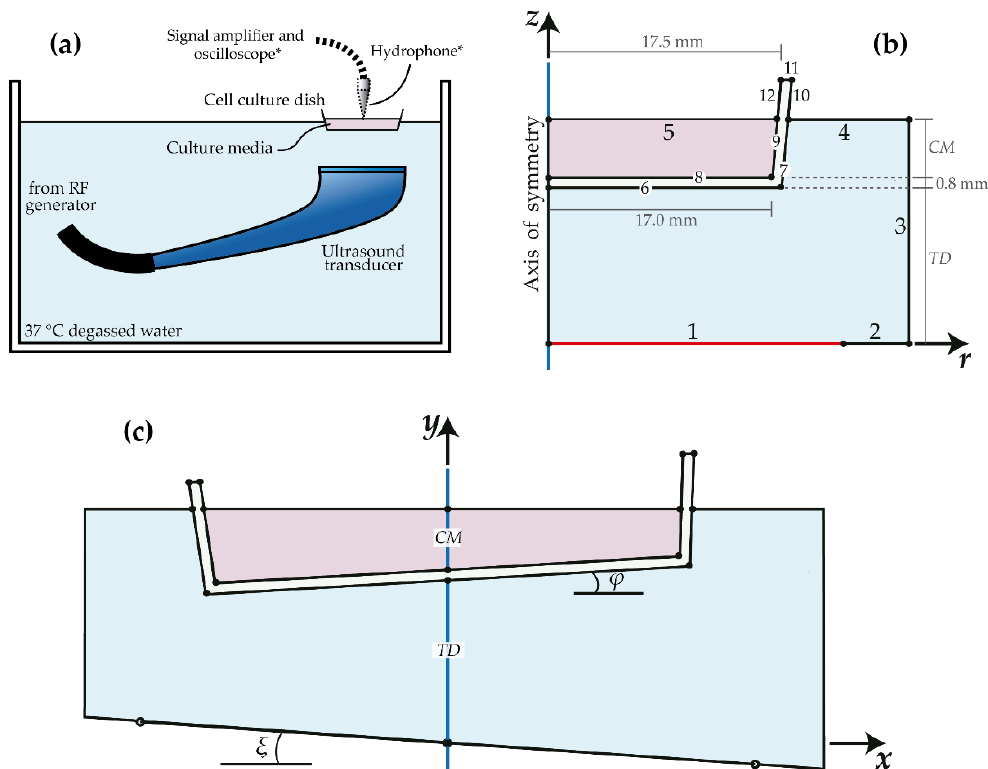
Figure 1. ( a ) Well-on-water-surface setup for ultrasound treatments. The components marked with (*) were used during the ultrasound transmission characterization. ( b ) 2D axisymmetric geometry for acoustic and thermal simulations. ( c ) 2D geometry for standing waves analysis (inclinations ξ and ϕ are not scaled). CM = depth of culture medium. TD = transducer to dish distance.